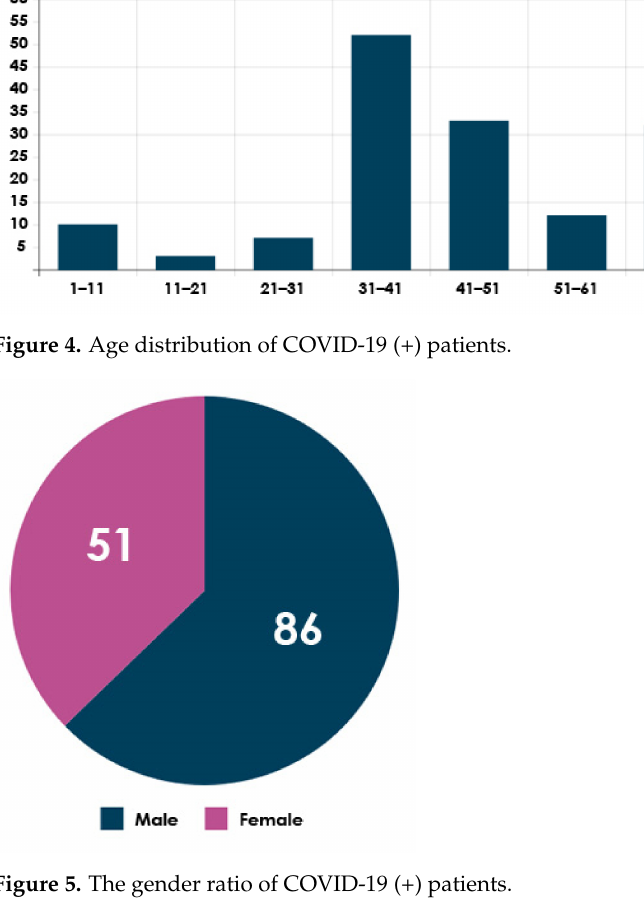
Figure 5. The gender ratio of COVID-19 (+) patients.